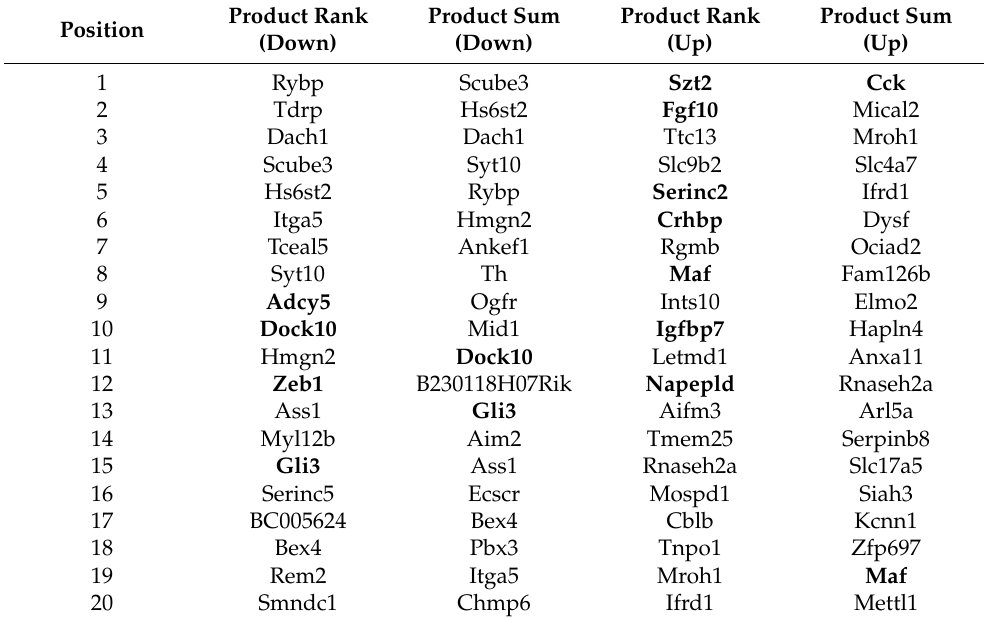
Table 2. Top 20 positioned genes in sum and product